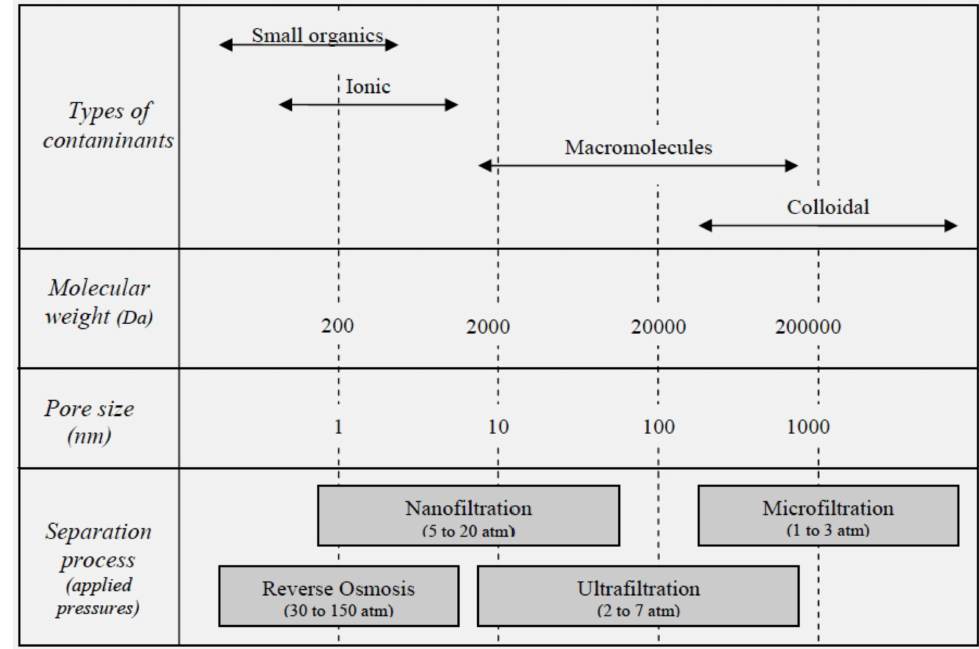
Figure 1. Filtration levels with equivalent particle rejection ranges and molecular weight